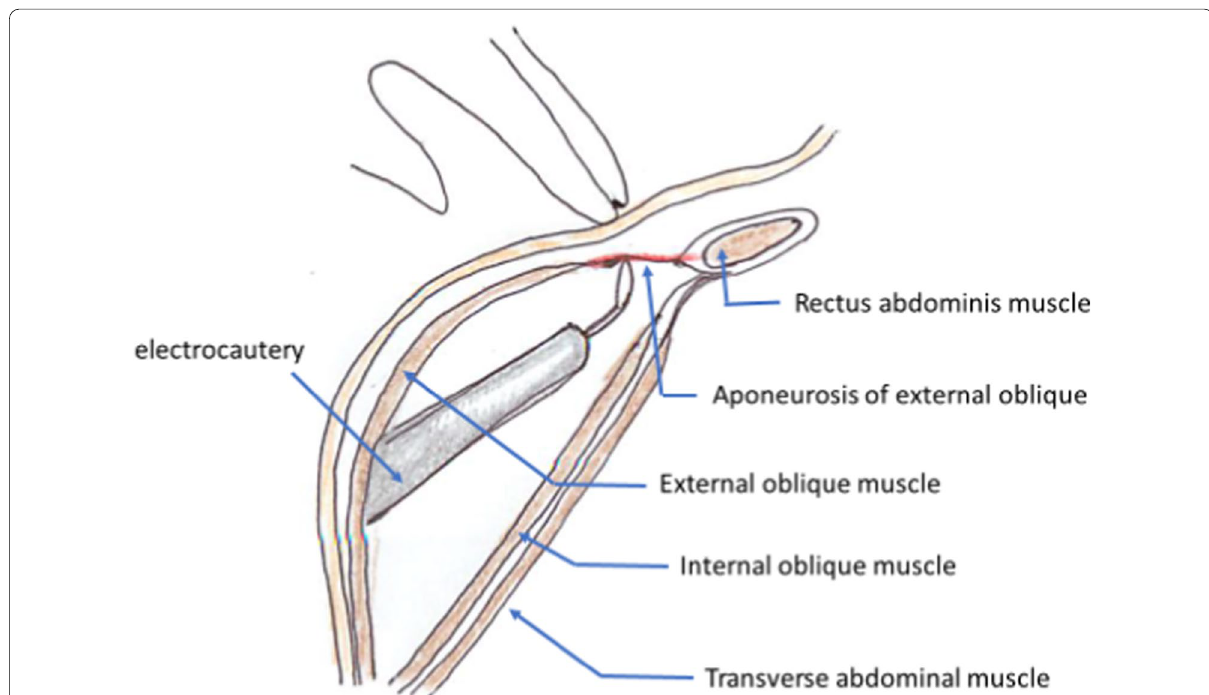
Fig. 4 A schema of the procedure. Electrocautery was inserted into the space between the external and internal oblique muscles, and the aponeurosis of the external oblique muscle was transected by a slight touch of electrocautery. The skin above was lightly pushed by surgeon’s finger which makes the aponeurosis stretched and transected easily